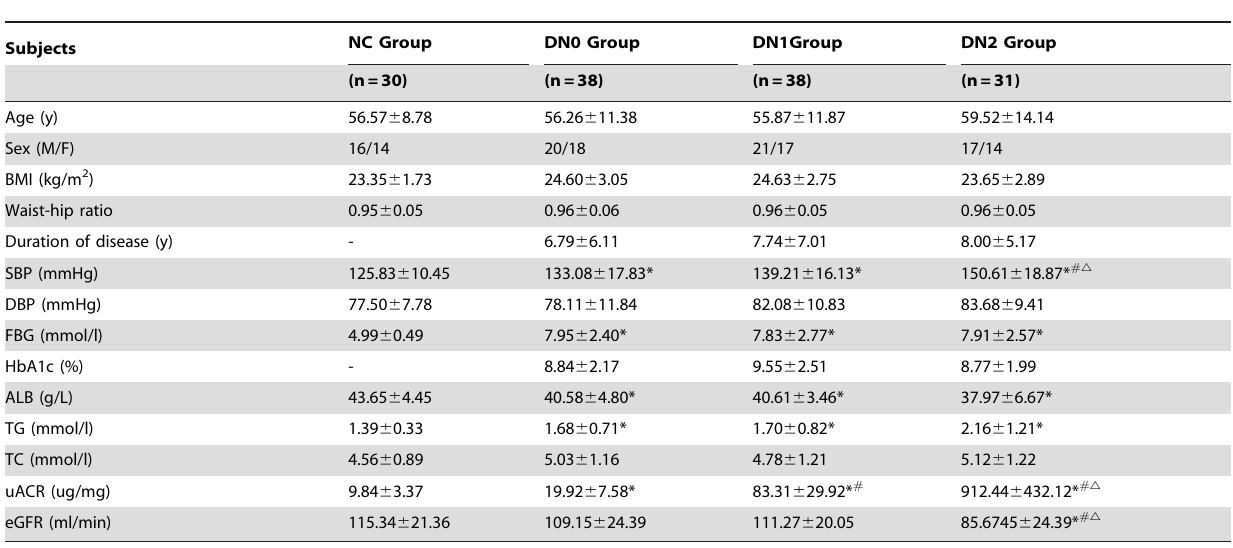
Table 1. Comparison of clinical data ( (cid:1) xx + s ).